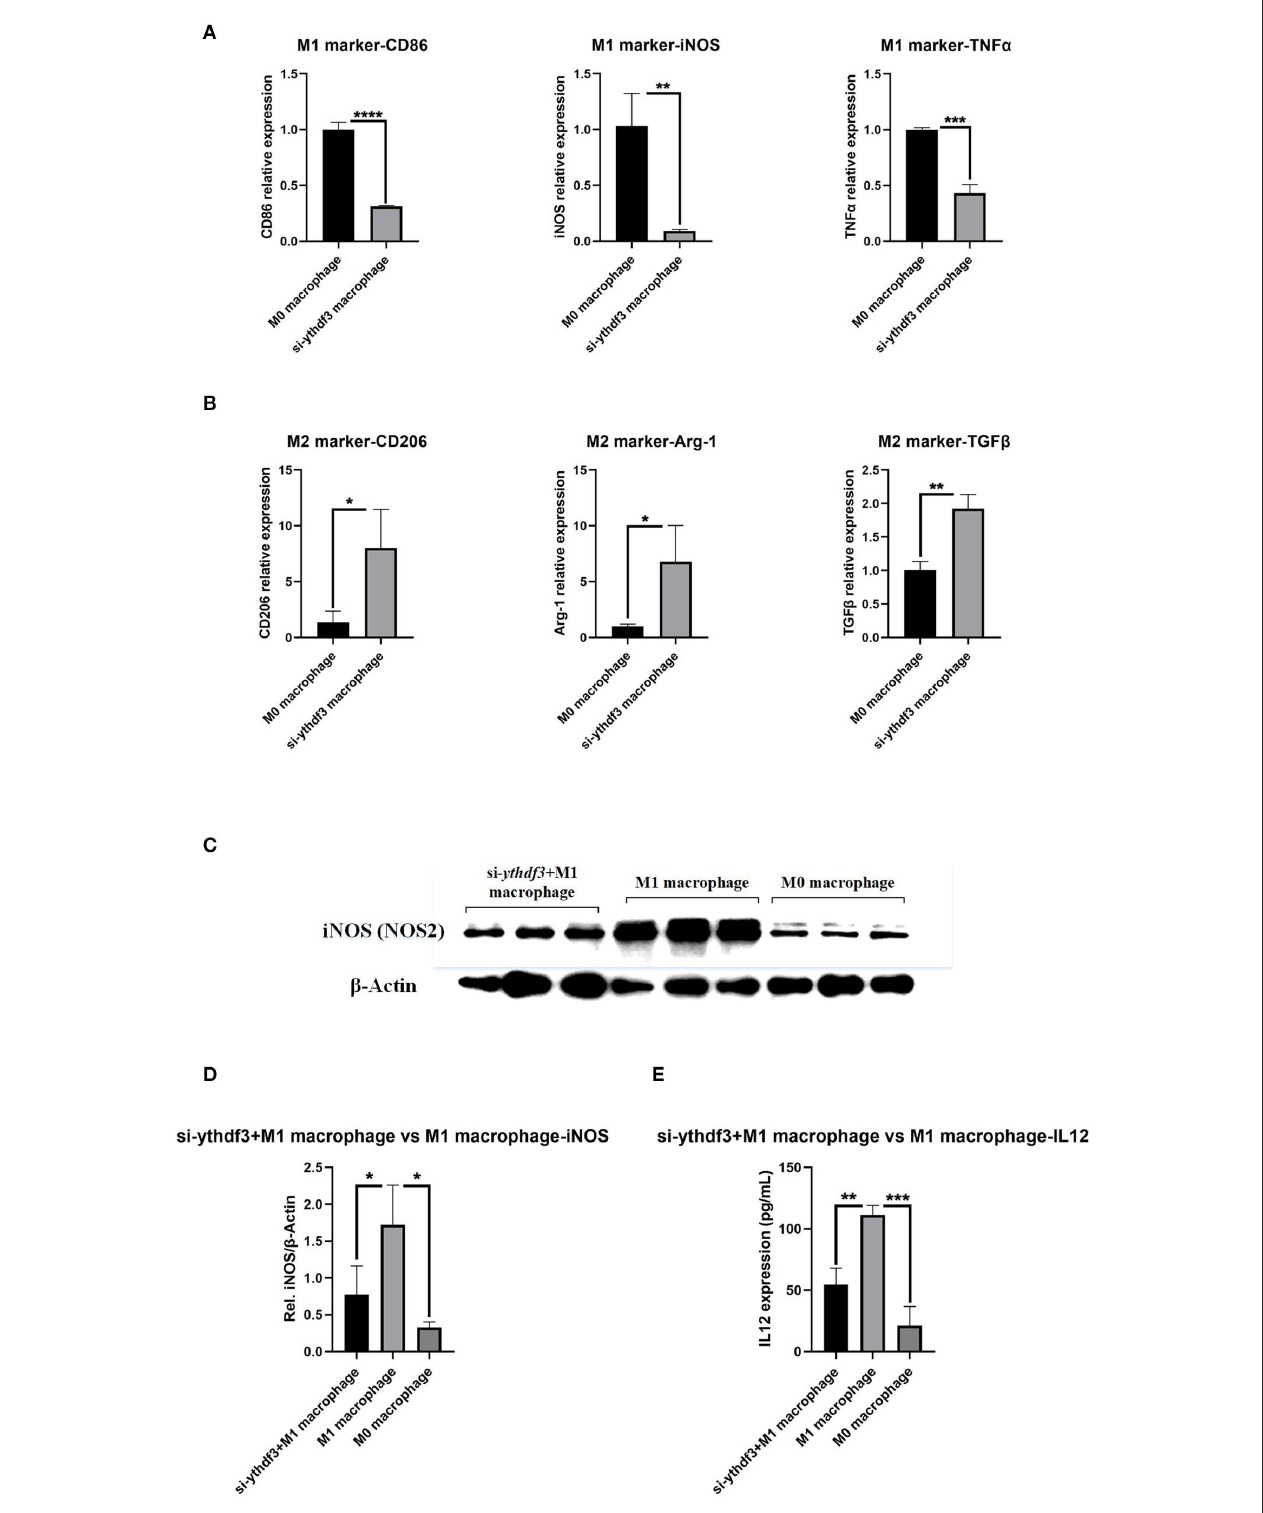
FIGURE 8 | The role of YTHDF3 in the M1/M2 polarization of M0 macrophages. YTHDF3 ; (A) The relative expression of M1 phenotype markers ( CD86 , iNOS and TNF α ) in M0 macrophages and si- ythdf3 macrophages, analyzed by RT-qPCR; (B) The relative expression of M2 phenotype markers ( CD206 , Arg-1 and TGF β ) in